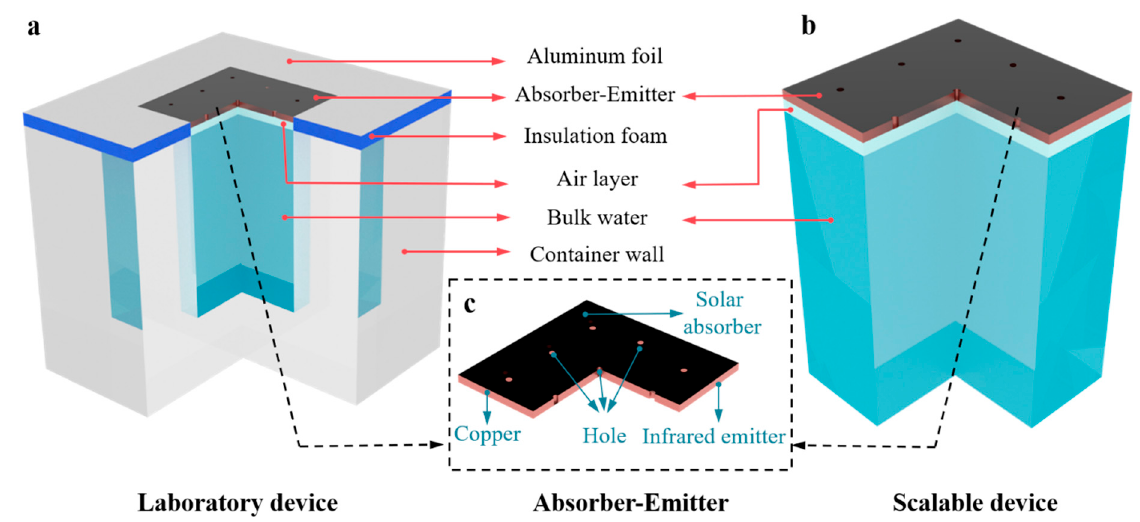
Figure 2. Schematic diagrams of ( a ) the laboratory SCE device, ( b ) the scalable SCE device and ( c ) the detailed layout of absorber–emitter of both devices. Table 1. Geometrical parameters of the laboratory and scalable